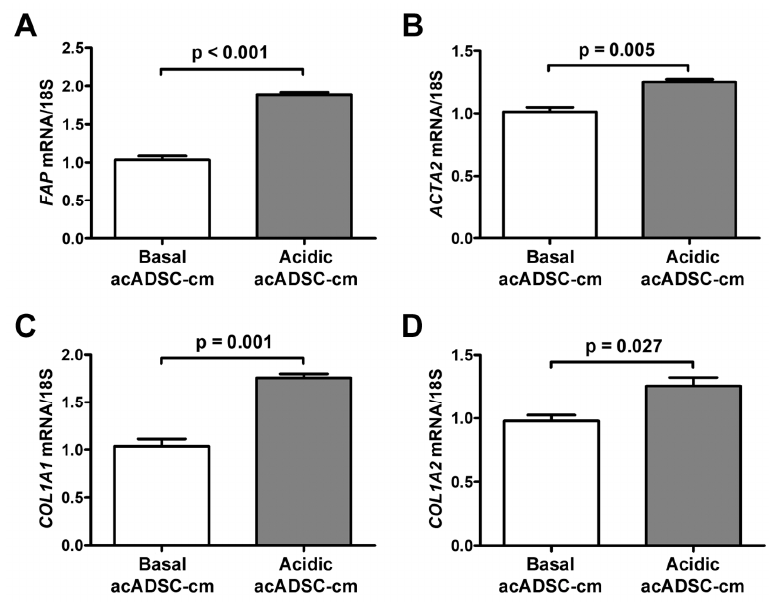
Figure 7. Quantitative real-time PCR analysis for the expression of the fibroblast activation/myofibroblast genes FAP ( A ), ACTA2 ( B ), COL1A1 ( C ), and COL1A2 ( D ) in normal human dermal fibroblasts treated for 24 h with conditioned media produced by adipocyte-committed adipose-derived stem cells (acADSCs) grown either under basal (pH 7.4) conditions (basal acADSC-cm) or under lactic acidosis (acidic acADSC-cm). The basal level of each gene expression was set to 1, and the other results are normalized to this value. 18S ribosomal RNA was used as the reference gene. Bars represent the mean ± SEM of three independent experiments ( n = 3 replicates each) from three cell lines. Values of p were determined by the unpaired Student’s t